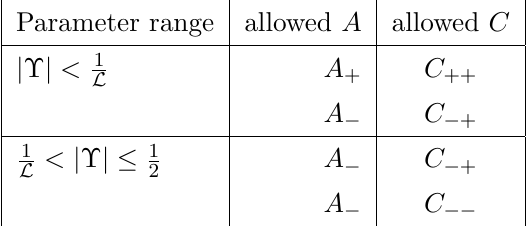
Figure 5 . s 2 + r 2 C = A (cid:0) L 2 and s 2 + ( (cid:0) +) r 2 C = A (cid:0) L 2 with L = 2 : 3 ; (cid:7) = 0 : ( (cid:0)(cid:0) )